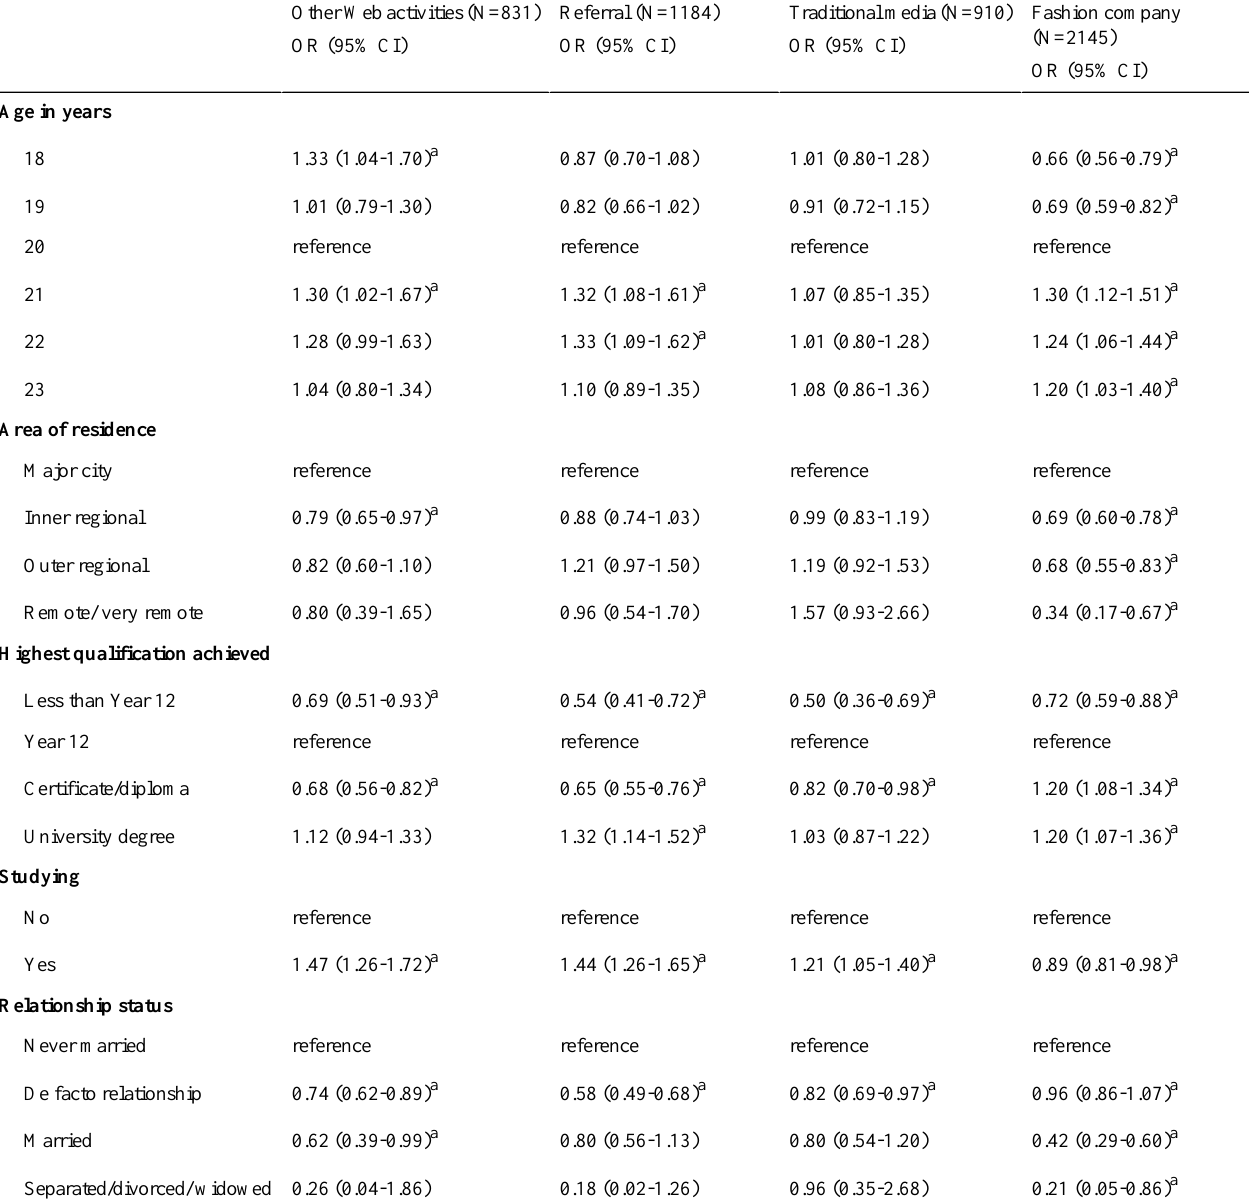
Table 3. Odds ratios for demographic characteristics by recruitment strategy of 18-23 year old women from the ALSWH 1989-95 cohort recruited October 2012-December 2013, using Facebook as the reference